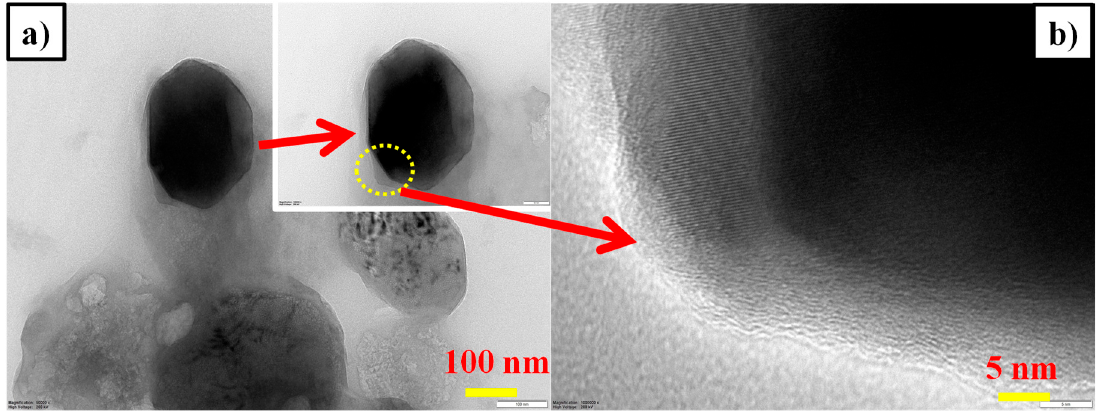
Figure 8. ( a , b ) TEM image of Li 2 FeSiO 4 / C after the 100th cycle (post-mortem).